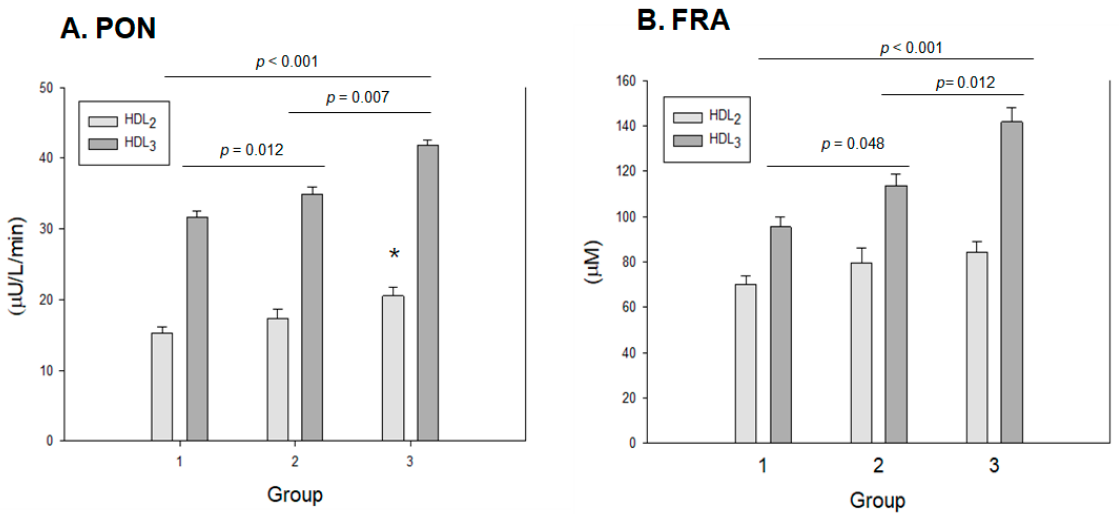
Figure 6. Antioxidant abilities of HDL 2 and HDL 3 from each group. Group 1 (n = 20); group 2 (n = 16); group 3 (n = 21). ( A ) HDL ‐ associated paraoxonase (PON) activity. PON activity is expressed as the initial velocity of p ‐ nitrophenol production per min ( μ U/L/min) at 37 °C during 60 min incubation. *, p < 0.05 versus group 1. ( B ) Comparison of HDL ‐ associated ferric ion reduction ability (FRA). FRA is expressed as the concentration of vitamin C (mM), which is equivalent to the amount of ferric ions ( μ M) reduced per hour.